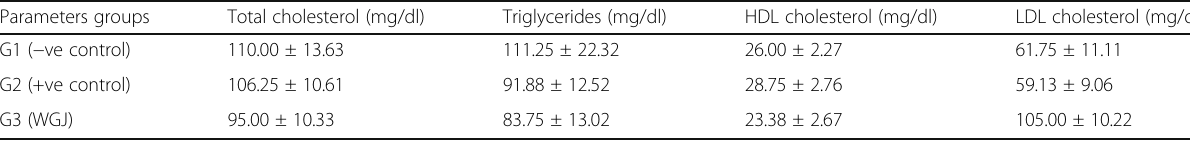
Table 7 The lipid profile of rat ’ s blood serum Parameters